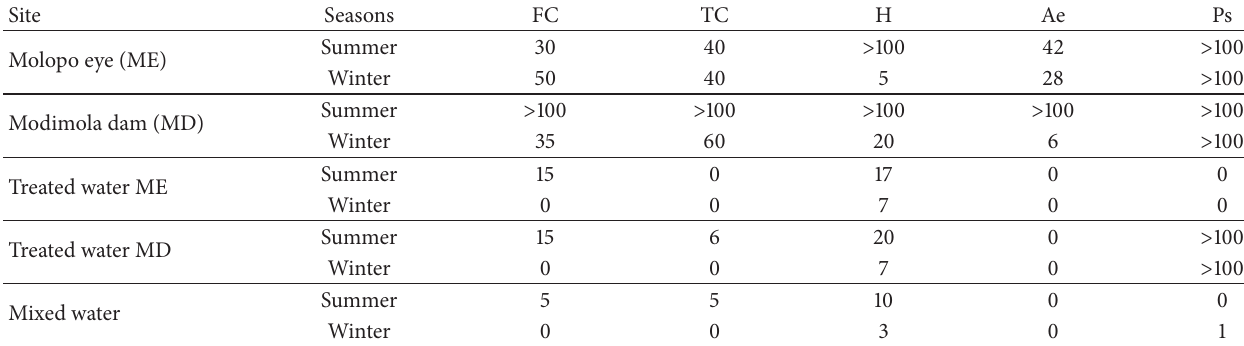
Table 3: Average number of microorganisms isolated.